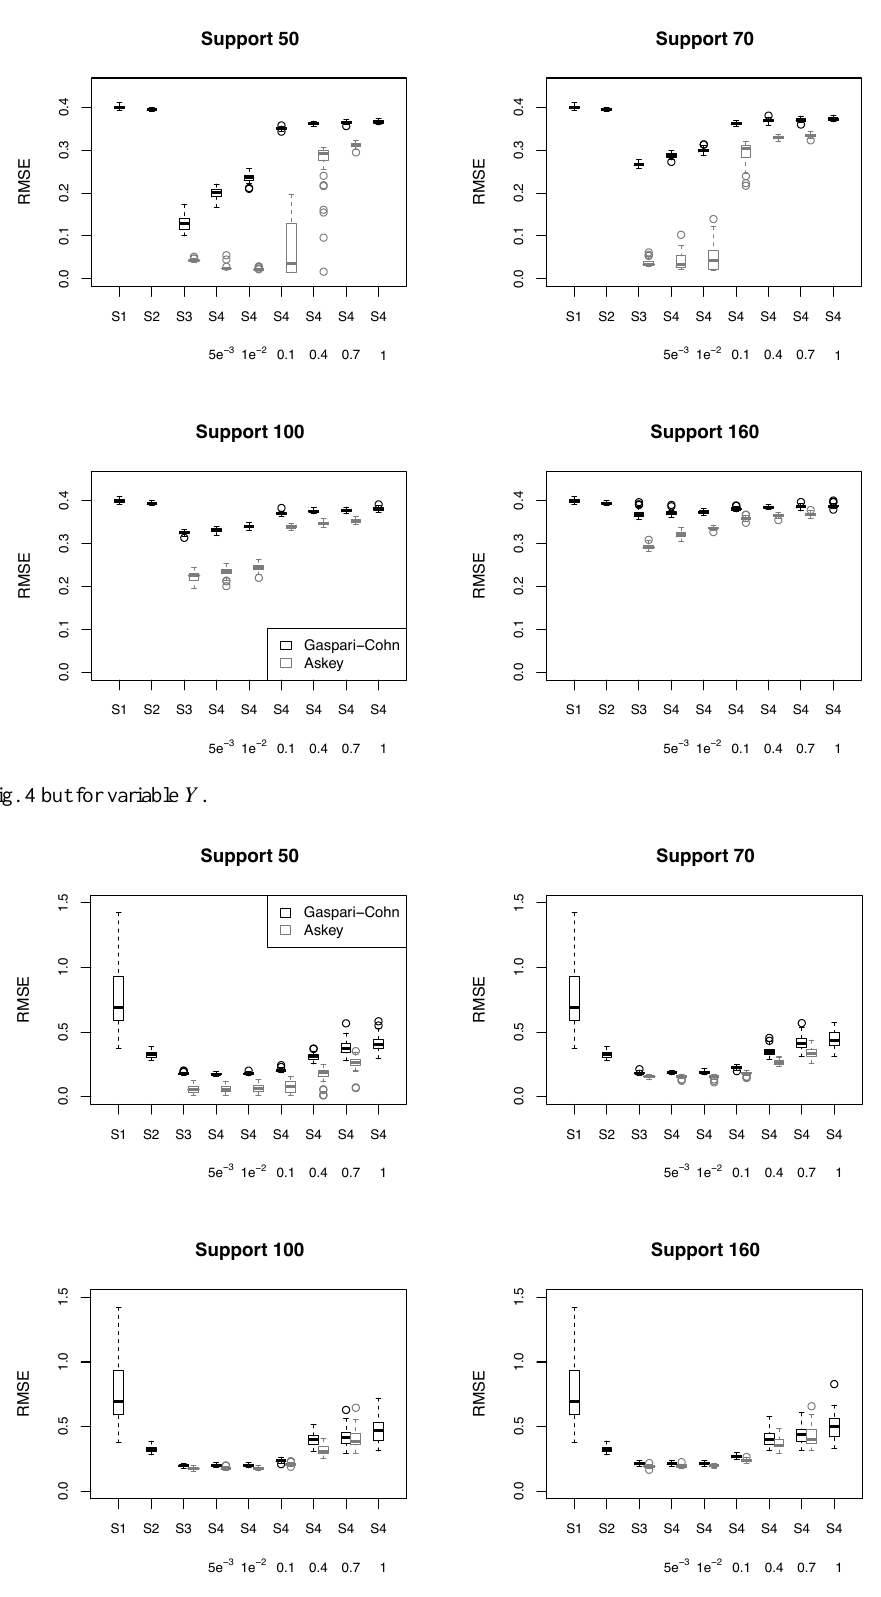
Figure 6. Same as Fig. 4 but for the case when the system is fully